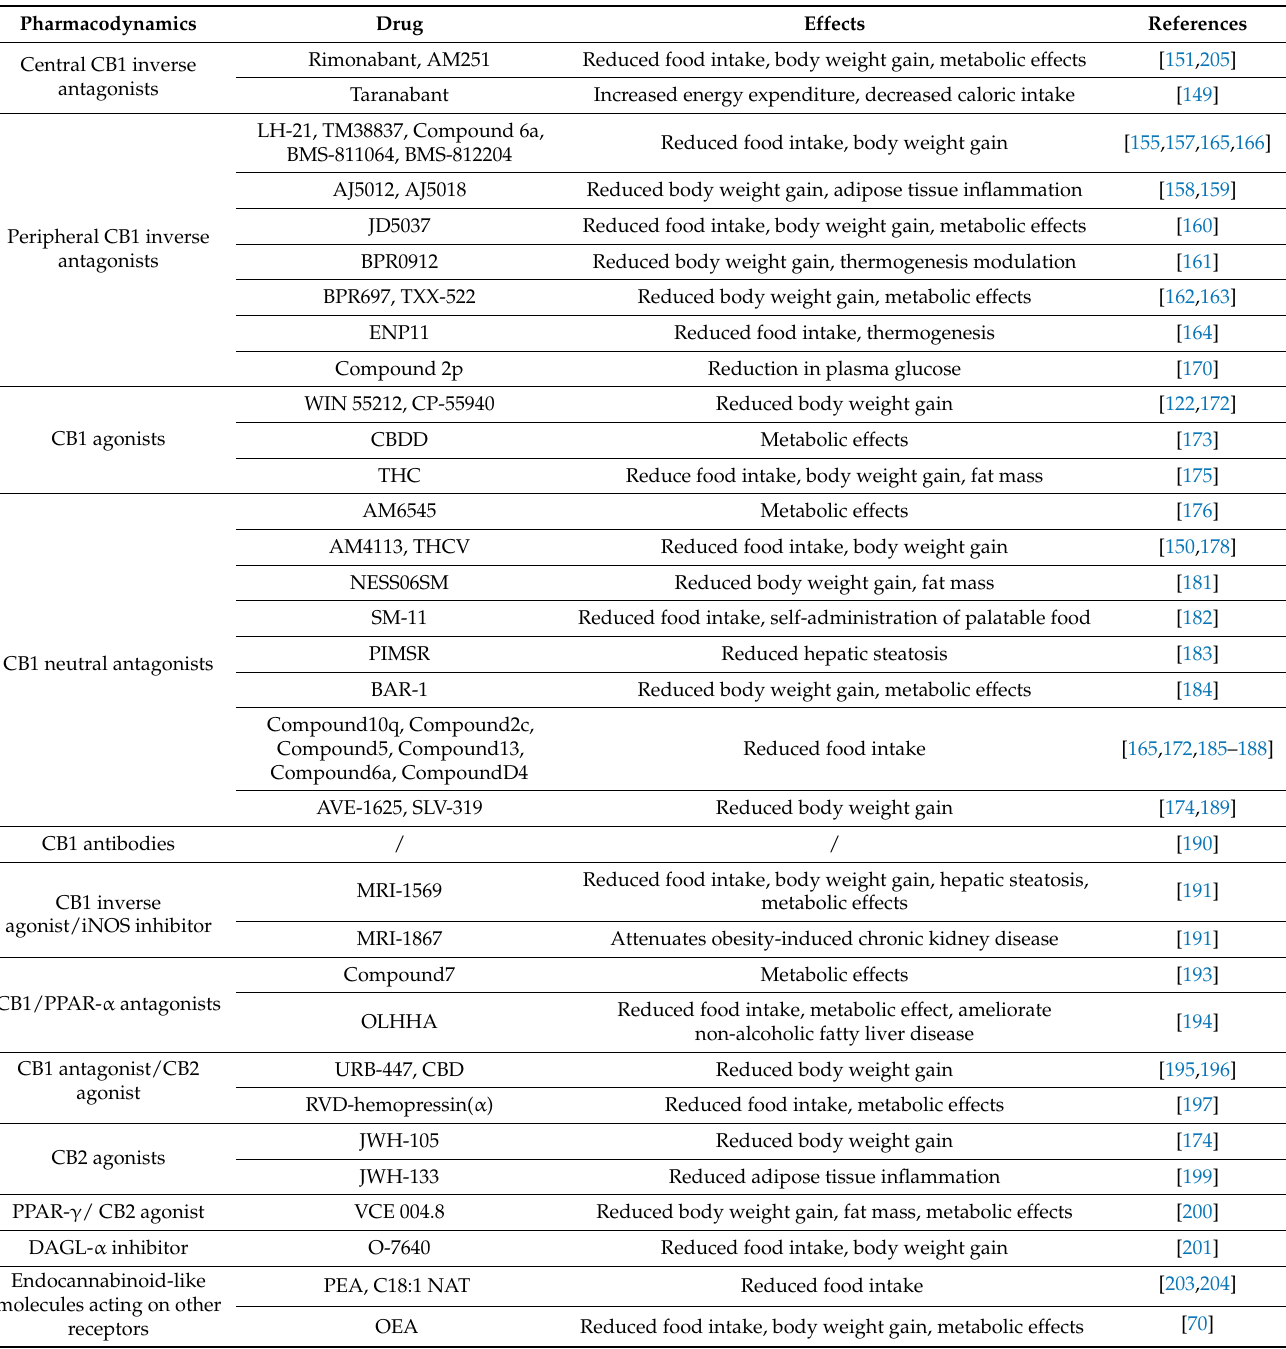
Table 1. Anti-obesogenic drugs acting on the endocannabinoid system and their relative pharmacodynamics. Abbreviations used in the table: CB1; cannabinoid receptor type 1, CB2; cannabinoid receptor type 2, iNOS; inducible nitric oxide synthetase, PPAR α ; peroxisome proliferated-activated receptor alpha, PPAR γ ; peroxisome proliferated-activated receptor gamma, DAGL; diacylglycerol